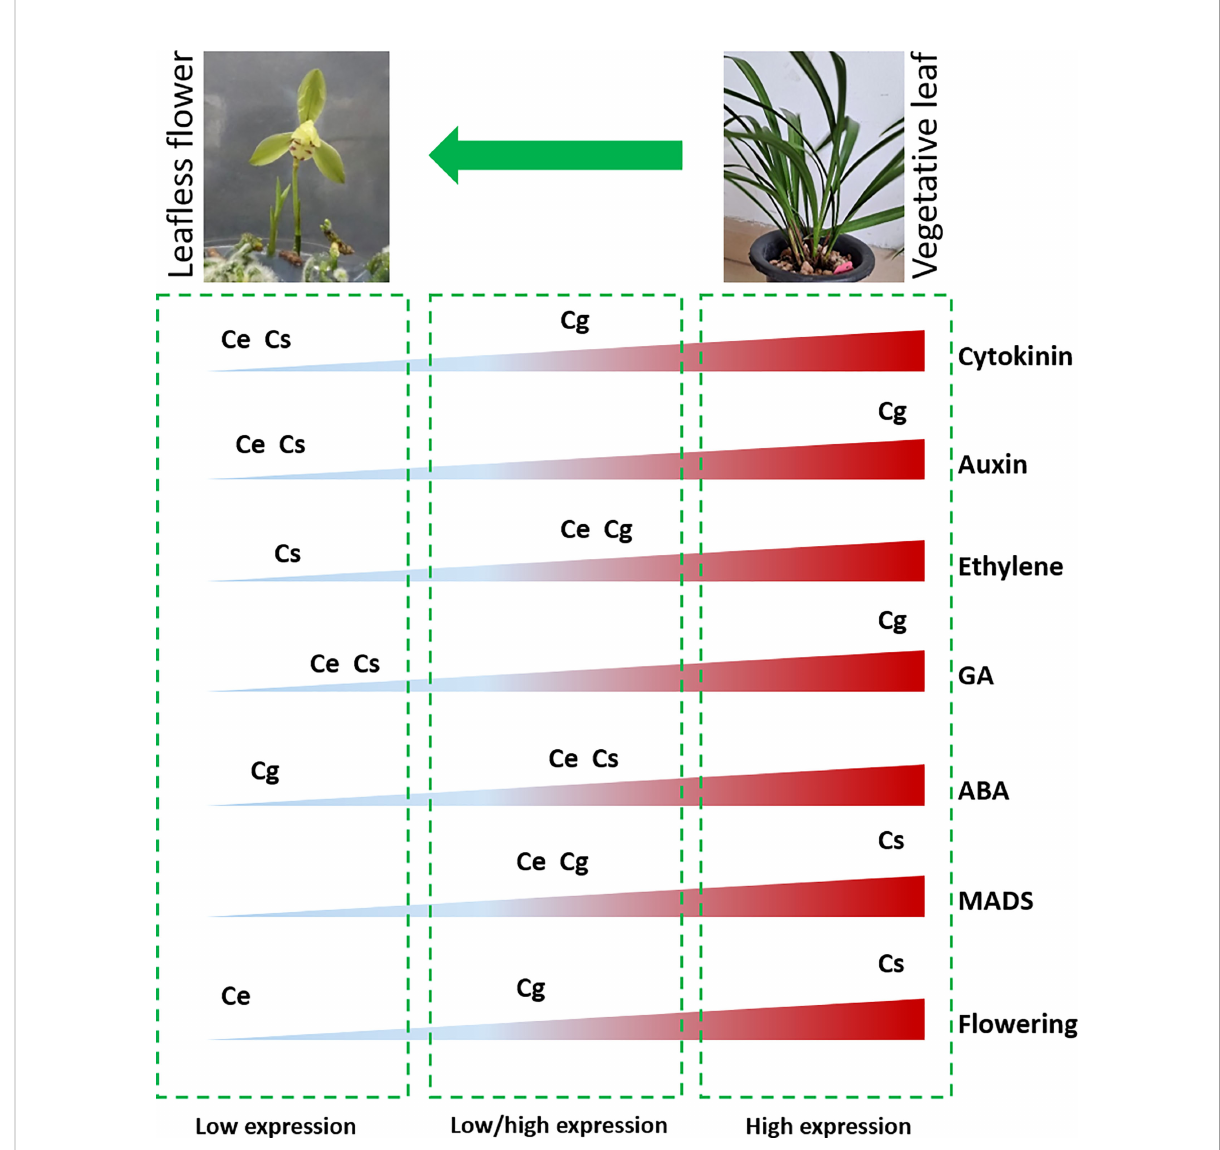
FIGURE 7 Overview of differential abundance of gene expression for fl owering and hormonal pathway genes between lea fl ess fl owers and healthy leaves (Ce: C. ensifolium; Cg: C. goeringii; Cs: C.